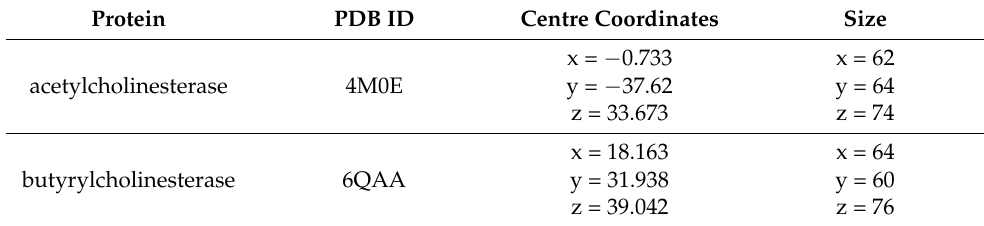
Table 1. Molecular docking parameters for cholinesterases.